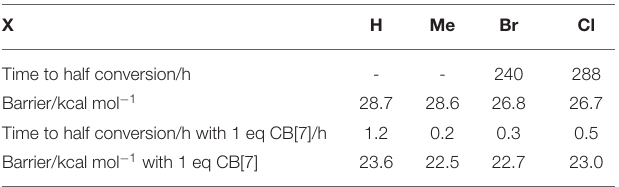
TABLE 1 | Summary of experimental kinetic data from Palma et al. (2017), barriers are calculated based on first order kinetics to allow direct comparison with calculations.